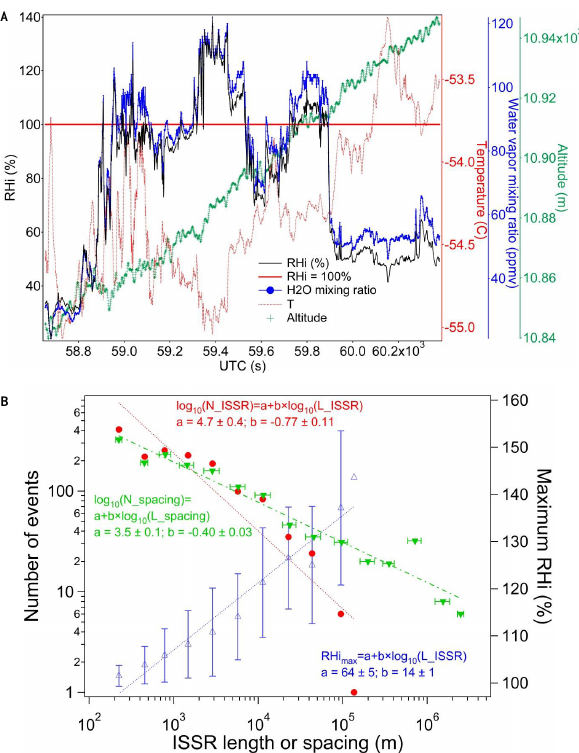
Fig. 6. Aircraft observation of ISSR. (A) An example of the air- craft observation time series of RHi (black line), H 2 O (blue line), T (red dotted line) and altitude (green line). The thick red line denotes RHi=100%. The ISSR 1-D segment lengths (L_ISSR) and the spacings (L_spacing) (blank area) between the ISSRs are calculated by multiplying the true air speed with the transect time inside and outside the ISSRs, respectively. The minimum scales are ∼ 230m (1s times 230ms − 1 mean true air speed). (B) Both ISSR segment length and spacing are binned by size between 2 i and 2 i + 1 (m), i = 1, 2, 3. The abscissa shows mean L_ISSR and L_spacing values in each bin. The left ordinate shows the number of events of ISSR seg- ment length (N_ISSR, red dots) and the number of events of ISSR spacing (N_spacing, green upside-down triangles) in each size bin. The right ordinate shows the mean RHi max value in each L_ISSR bin (blue open triangles). A power law fit is applied to the N_ISSR versus L_ISSR, i.e., log 10 (N_ISSR)= a + b × log 10 (L_ISSR) (red dotted line). Similarly, a power law fit is applied to N_spacing ver- sus L_spacing, i.e., log 10 (N_spacing)= a + b × log 10 (L_spacing) (green dashed line). A linear fit is applied to RHi max versus the log- scale L_ISSR, i.e., RHi max = a + b × log 10 (L_ISSR) (blue dotted line). For all linear fits in this study ± σ means ± 1 standard devia- tion. Intercepts and slopes of the linear fits for all the graphs in this work are represented by values a and b in the legend,